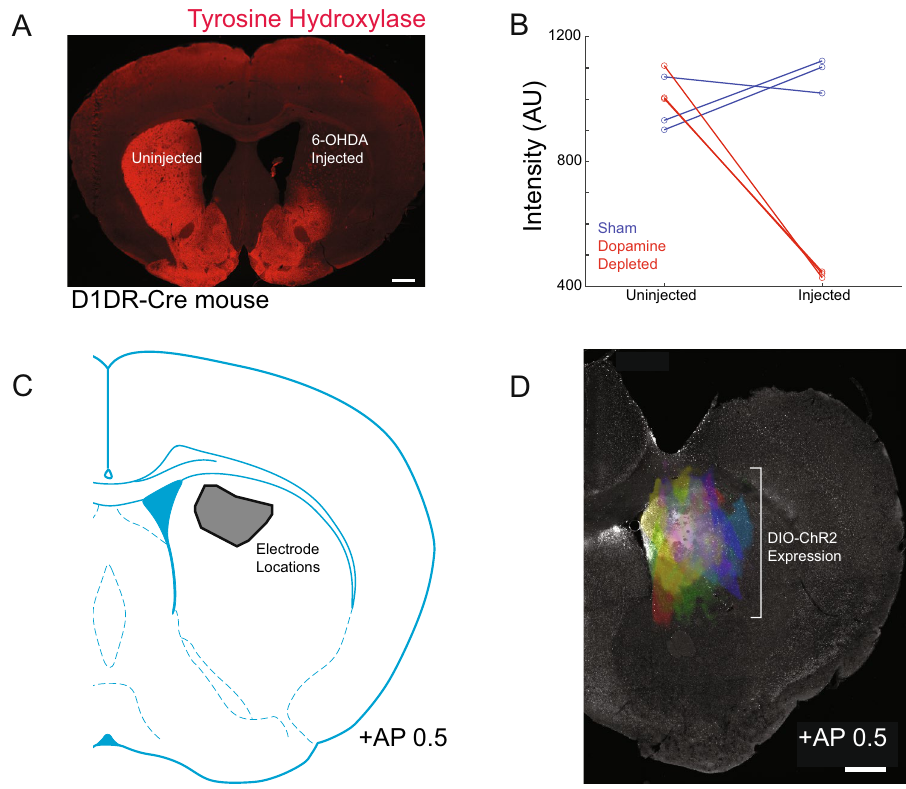
Figure 2. Dopamine depletion, recording, and viral expression: ( A ) we depleted dopamine by injecting 6-OHDA in the dorsal striatum of D1DR-Cre mice. The terminals of dopamine neurons expressing tyrosine hydroxylase are stained in red. Scale bar 500 μm. ( B ) Tyrosine hydroxylase fluorescence was reliably decreased in 6-OHDA dopamine depleted animals (red) compared to sham animals that underwent identical procedures except with saline injected into the dorsal striatum (blue). ( C ) Electrode locations in the dorsomedial striatum. ( D ) Viral DIO-ChR2 expression in D1DR-Cre mice; each color is an individual animal, aligned to a background image from a single animal. Data in ( B – D ) from 3 dopamine-depleted and 3 sham animals. Scale bar 500